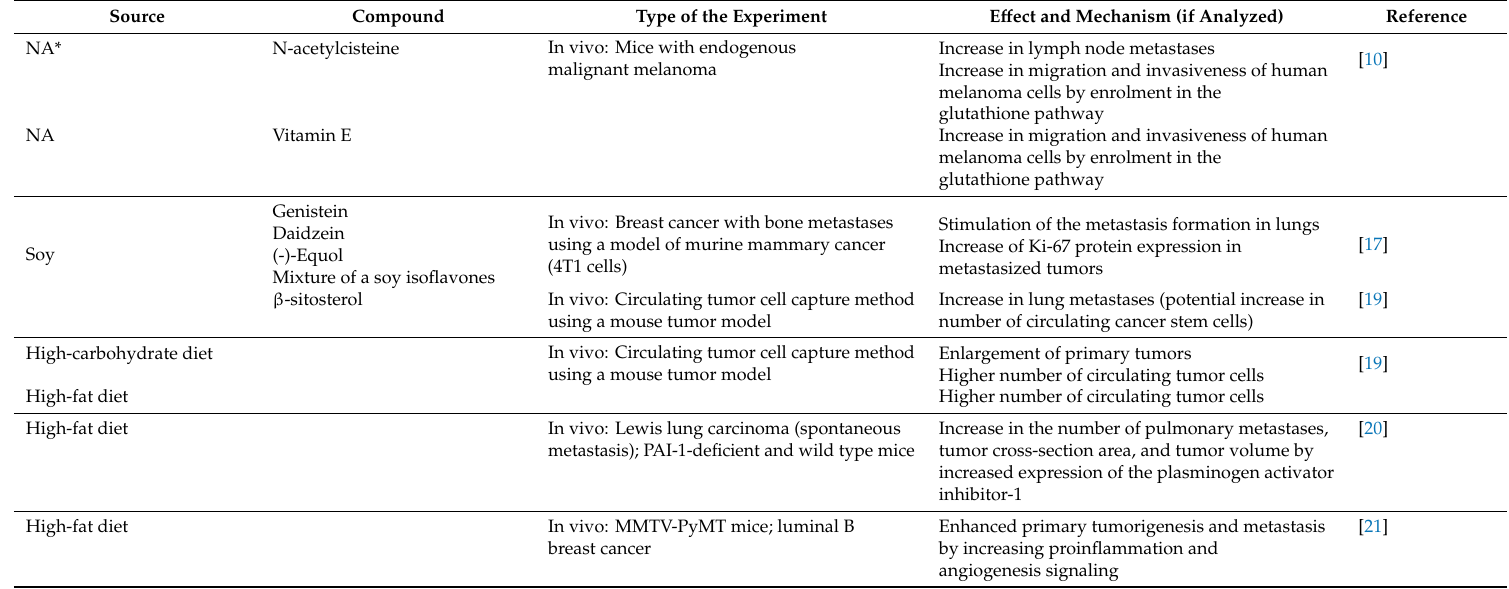
Table 1. List of biologically active compounds that could promote metastasis